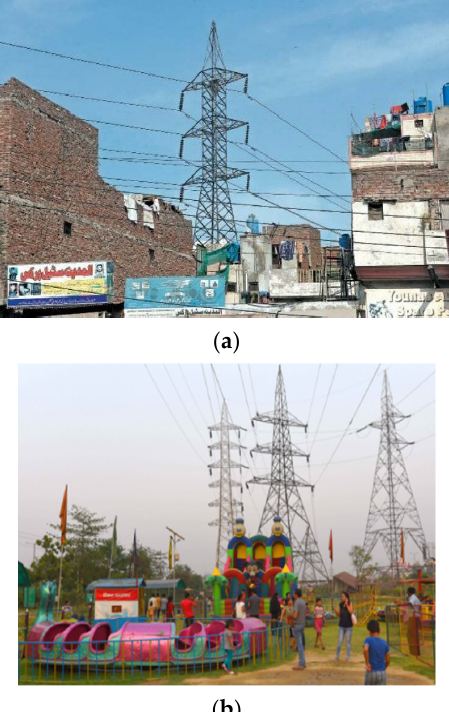
Figure 1. ( a ) Infringement of right of way of transmission line due to infrastructure expansion and ( b ) housing buildings in children’s parks in [6,7]. ( b ) housing buildings in children’s parks in